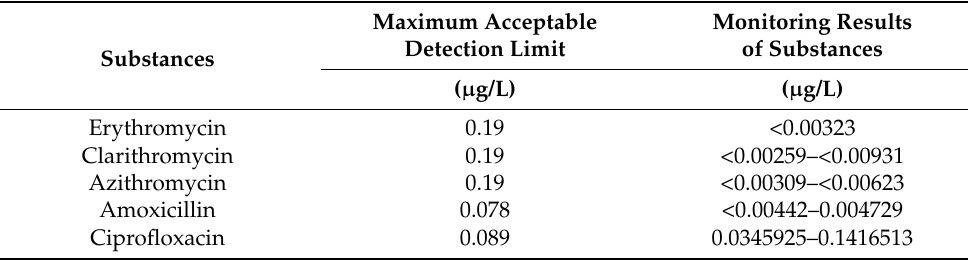
Table 1. Antibiotics listed on the second Watch list, their maximum acceptable detection limit and monitoring results in Croatia [14]. Maximum Acceptable Monitoring Detection Limit Substances